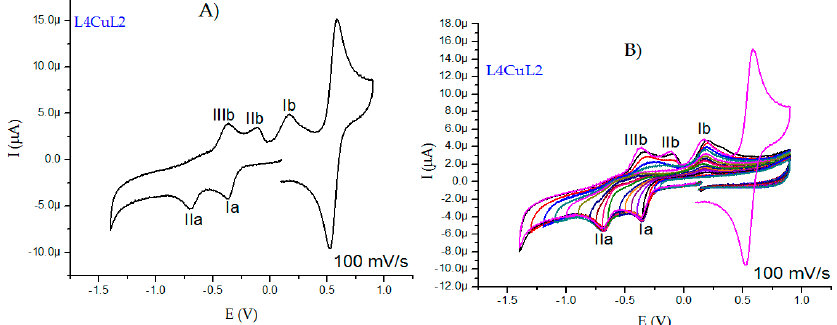
Figure 8. Cyclic voltammograms for 0.001 M of L4CuL2 in DMSO with 0.1 M tetrabutylammonium hexafluorophosphate. ( A ) Voltammograms at 100 mV/s and ( B ) inversion study at 100 mV/s. All the experiments were referenced to the pair Fc + /Fc.